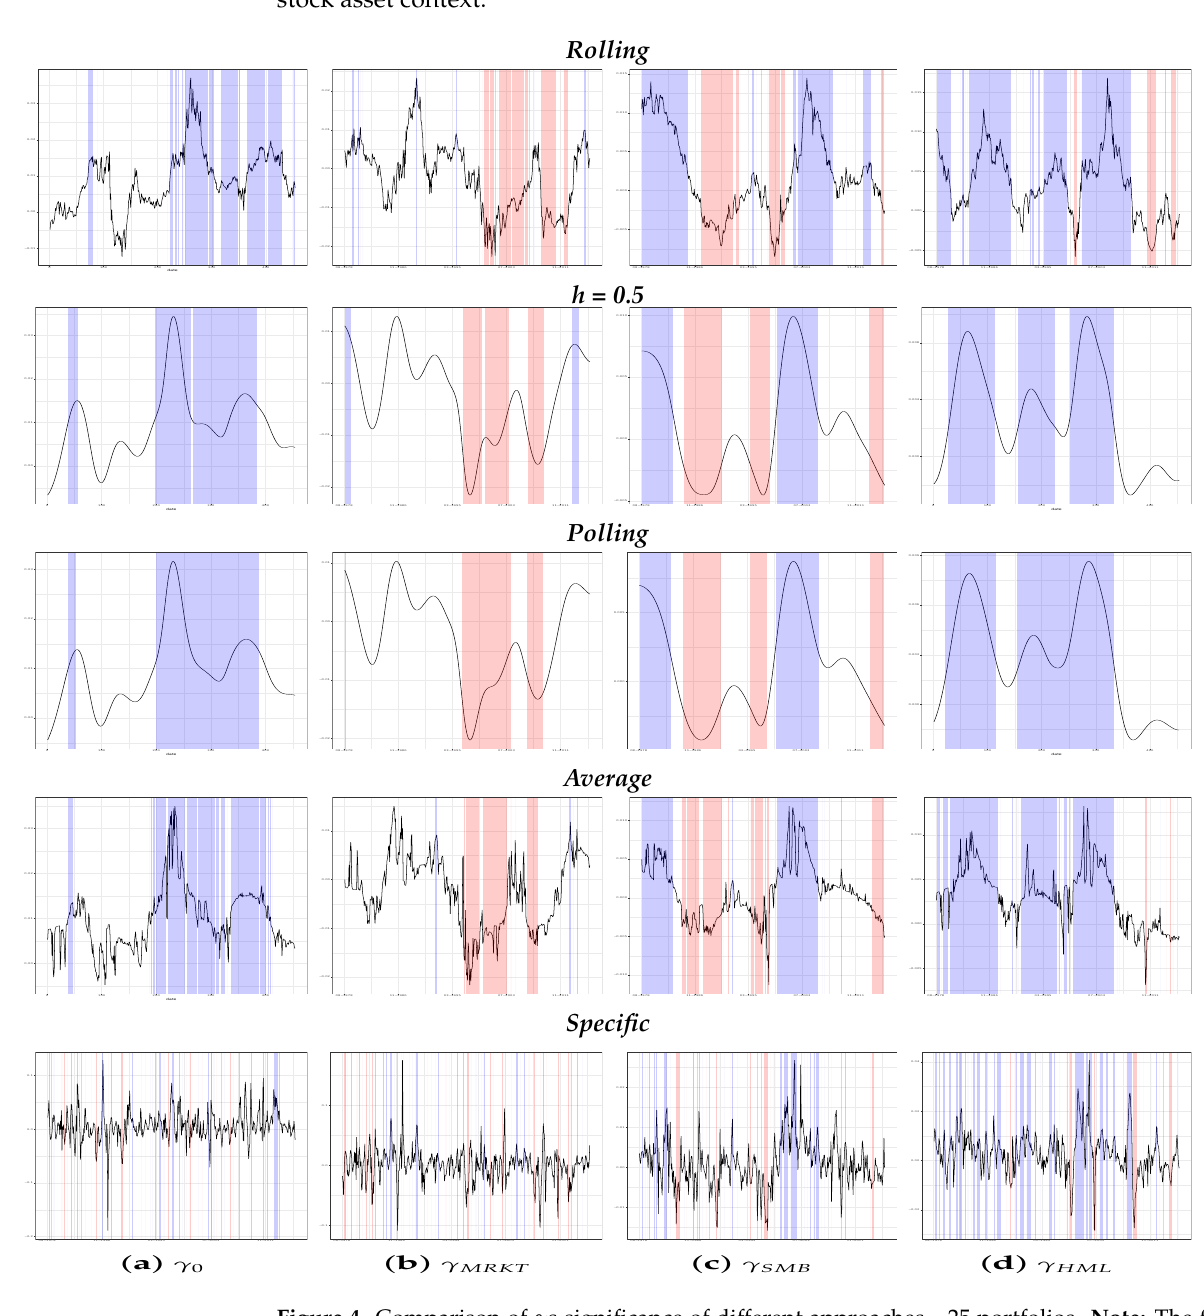
Figure 4. Comparison of γ s significance of different approaches—25 portfolios. Note: The figure provides a significance analysis of the estimates of risk premium estimates. The blue areas are periods in which the estimates are statistically positive at a 5% level of significance, while the red ones identify periods in which the estimates are negative. The series were computed using different approaches: Rolling window ( FMcB approach), h = 0.5; Polling a single value of h coming from the poll average across assets and time (Equation (7)); Average , a unique time-varying bandwidth coming from the average of h across assets (Equation (8)); Specific , multiple time-varying bandwidths, one for each asset and time. The choice of the optimal bandwidth parameter h opt has been made using the kernel t approach as discussed in Equation